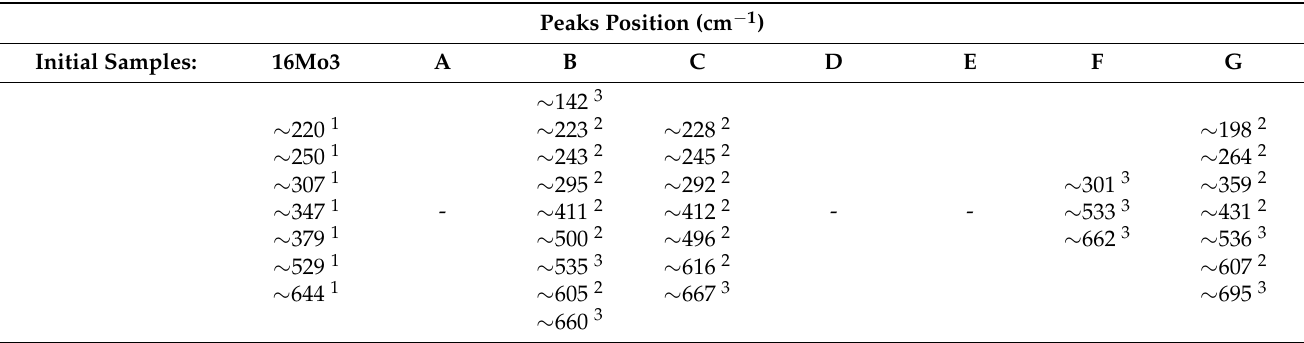
Table 4. Raman peaks position and corresponding